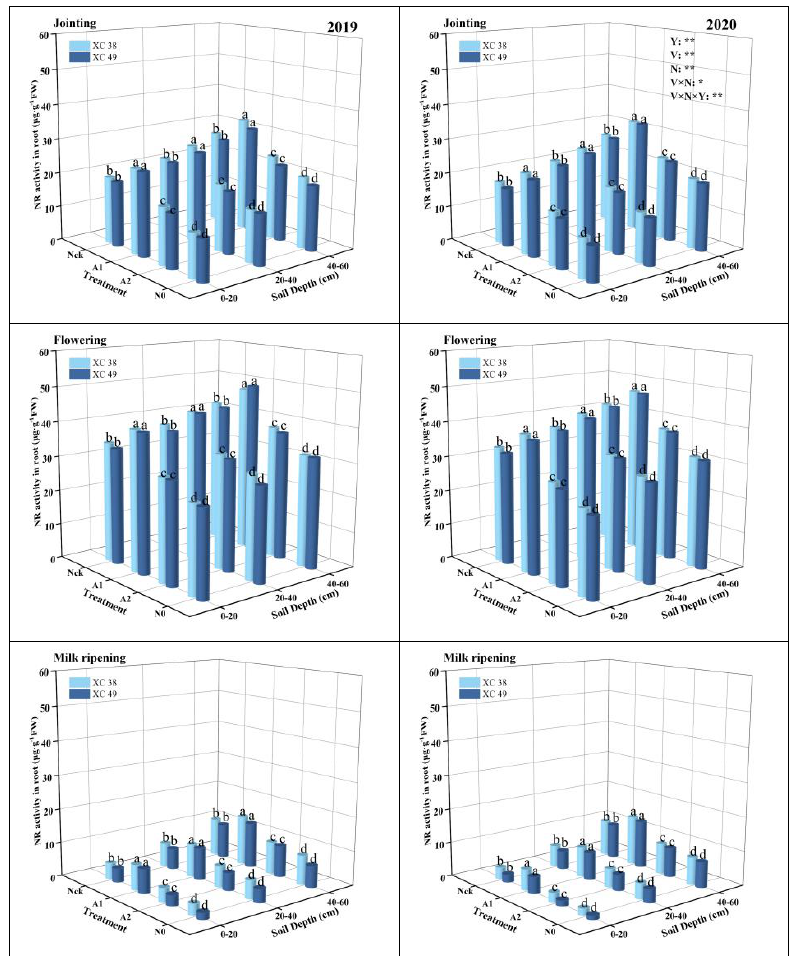
Figure 2. Effect of nitrogen supply on root NR activity of drip-irrigated spring wheat. Note: XC 38: Xinchun 38; XC 49: Xinchun 49. Nck: 300 kg·ha −1 ; N0: 0 kg·ha −1 ; A1: 240 kg·ha −1 ; A2: 210 kg·ha −1 . V: variety, N: different nitrogen treatments, and Y: year. “*” and “**” indicate significant differences at 0.05 and 0.01 levels, ns indicates insignificant differences. Different lowercase letters indicate significant differences between treatments at the 0.05 level.